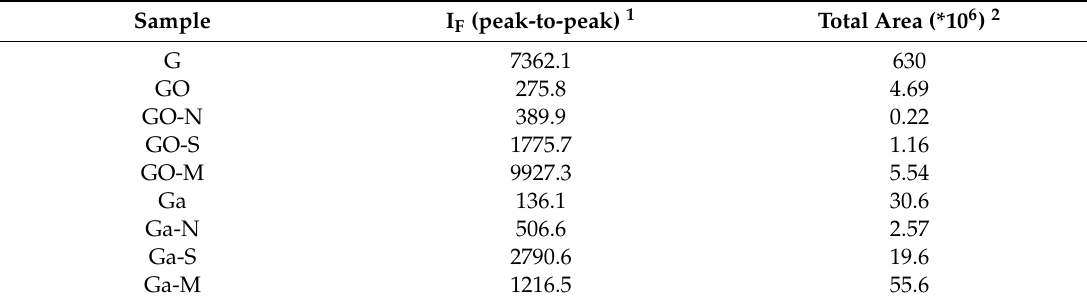
Table 3. ESR results of the modified graphene samples.